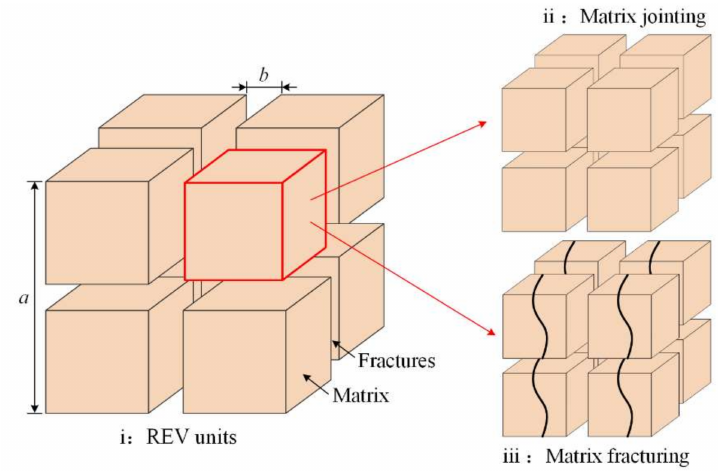
Figure 6. REV description of weakly cemented